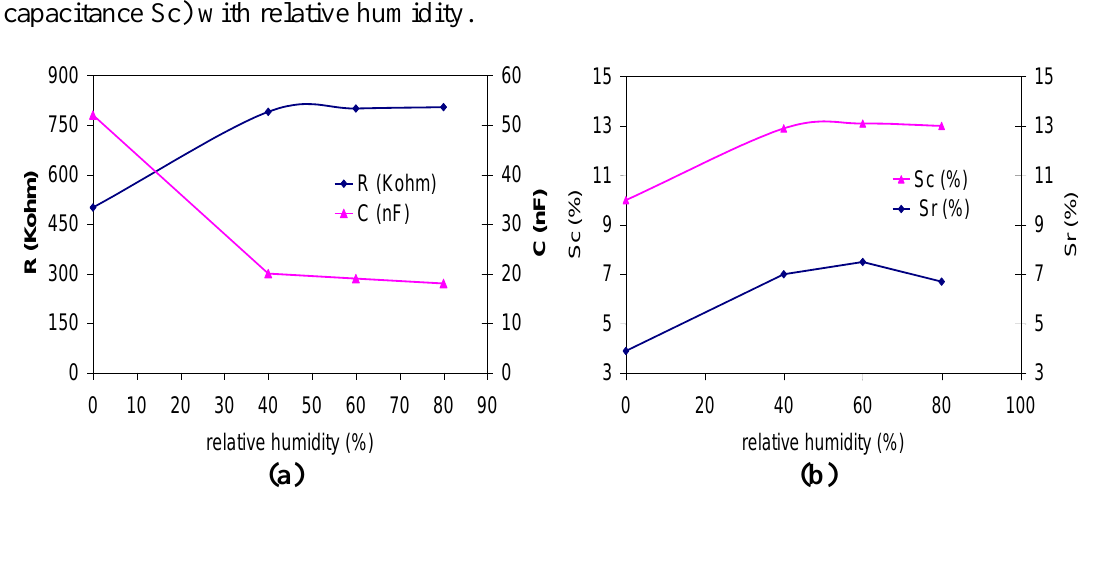
Figure 6. (a) Change in the resistance and capacitance baseline with relative humidity. (b) Change in the sensor response to 5,000 ppm (in terms of resistance Sr and in terms of capacitance Sc) with relative